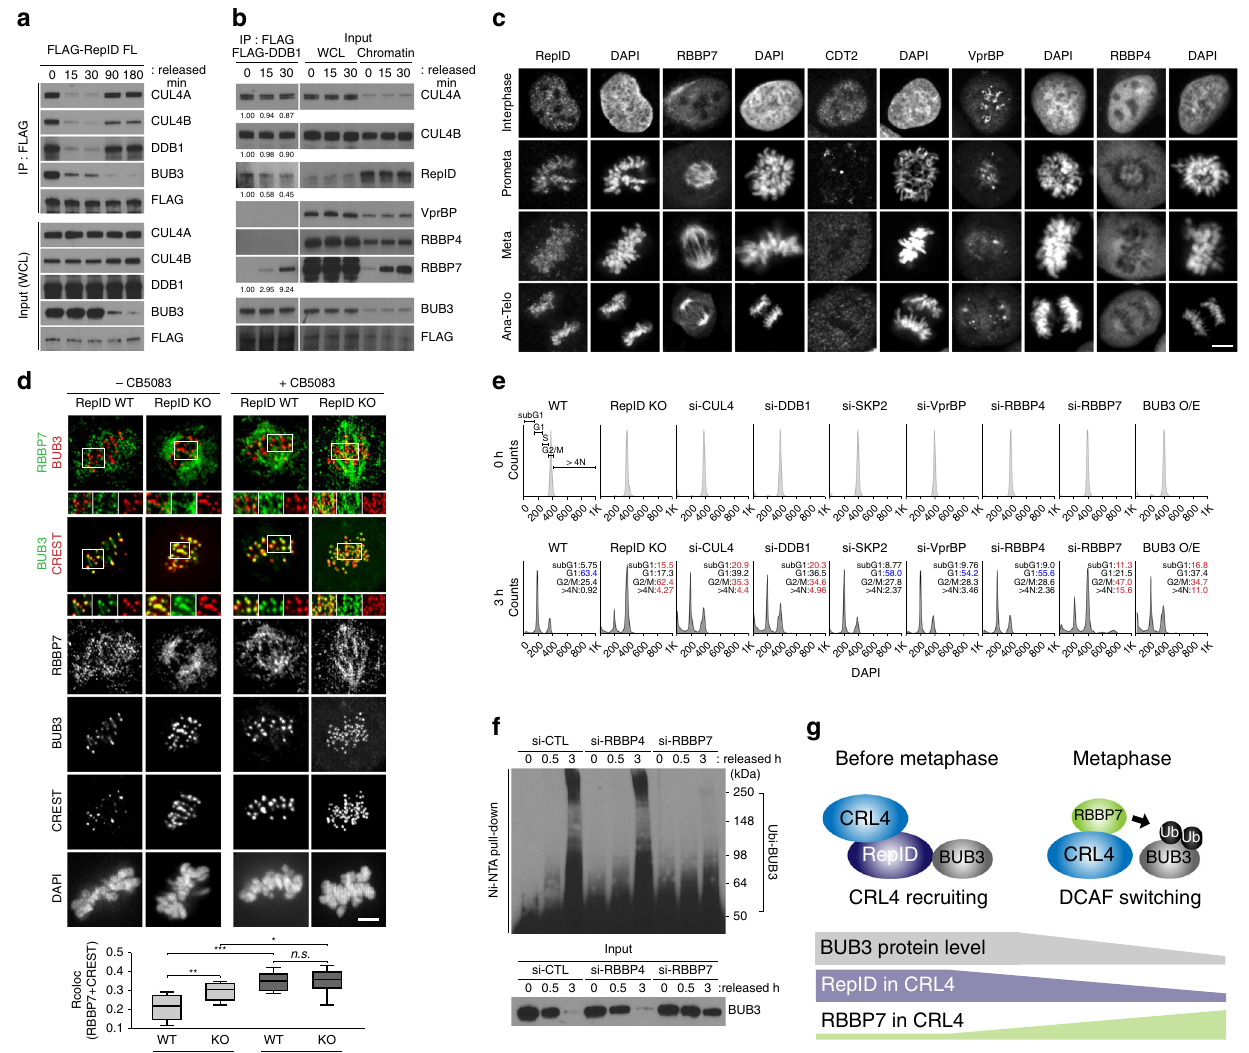
Fig. 4 RBBP7 is incorporated into CRL4 and facilitates BUB3 ubiquitination. a RepID dissociates from CRL4 during mitotic progression. HCT116 cells were transfected with RepID FL expression plasmid (for constructs, see Fig. 2b). Cells were collected at the indicated times after release from a nocodazole block, and chromatin-bound fractions were extracted. Immunoprecipitation was performed using anti-FLAG antibody, and co-precipitated proteins were analyzed by immunoblotting. b RBBP7 is incorporated into CRL4 after mitosis. Chromatin fractions of FLAG-DDB1-transfected HCT116 cells released from mitotic block at the indicated time points were immunoprecipitated with anti-FLAG antibody, followed by immunoblot analysis. c RBBP7, but not other DCAFs, localizes to mitotic spindle during mitosis. Immuno fl uorescence analysis was performed using the indicated anti-DCAFs antibodies in HCT116 WT cells. Scale bar: 10 μ m. d RBBP7 colocalizes with BUB3 during metaphase. HCT116 RepID WT or KO cells were subject to immuno fl uorescence analysis using anti-RBBP7, BUB3, and anti-CREST antibodies with/without treatment with a p97/VCP inhibitor (CB5083). Zoomed-in areas (marked by white squares) are shown at the bottom of the composite images (merged images of the zoomed-in area are shown to the left of the single-color zoomed-in images). Scale bar: 10 μ m. Quanti fi cation of colocalization between RBBP7 and BUB3 by Pearson ’ s correlation coef fi cients (bottom panel) (* p value < 0.05, ** p < 0.01, *** p < 0.001, n.s. not signi fi cant, Student ’ s t test). e Depletion of RepID-CRL4 RBBP7 components or BUB3 overexpression can delay mitotic exit. Depleted or overexpressed HCT116 cells were released from a nocodazole arrest for 3 h and analyzed by fl ow cytometry. Percentages of cells in subG1, G1, G2/M, and >4 N phase are indicated. f RBBP7 facilitates the ubiquitination of BUB3 during mitosis. HIS-ubiquitin plasmids were transfected into HCT116 RepID WT cells together with siRNA-RBBP4 or si-RBBP7. Cells were synchronized, released, lysed, and proteins isolated on Ni-NTA beads as described in the legend for Fig. 3e. Immunoblot analysis was carried out using anti-BUB3 antibodies. g A model describing the DCAF switch on chromatin during mitosis. RepID recruits CRL4 on chromatin before metaphase, bringing CRL4 in contact with BUB3. RepID then dissociates from CRL4, and RBBP7 is incorporated into CRL4 as a catalytic DCAF for BUB3